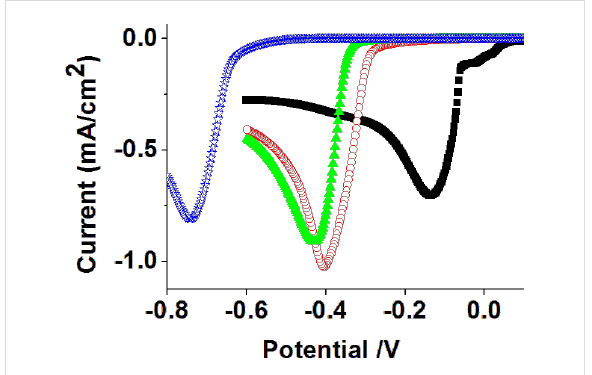
Figure 3: Linear-sweep voltammograms comparing the electrodeposi- tion of Cu on clean (black squares) and SAM modified Au/Si elec- trodes, from a 50 mM CuSO 4 /0.1 M H 2 SO 4 electrolyte. SAMs were prepared by 24 h immersion of Au/Si substrates into solutions of octadecane thiol (blue stars) at room temperature and of MBP0 at room temperature (red circles) and 65 °C (green